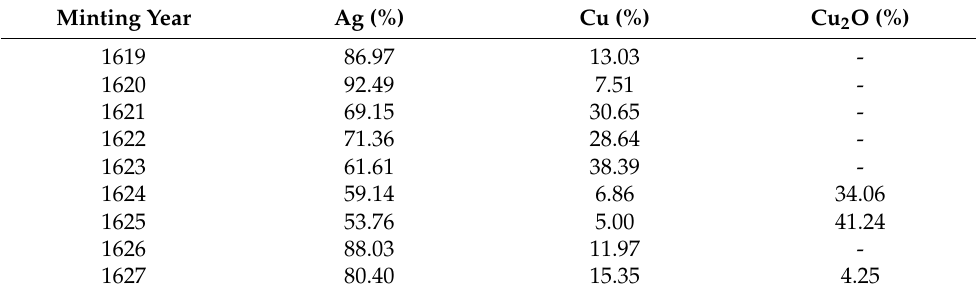
Table 2. Phase composition of the investigated 3-Polker